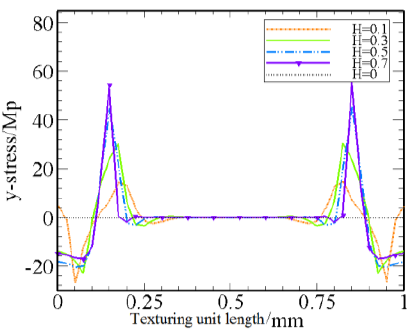
Figure 8. Distribution of stresses along the y –direction at different texturing depths.